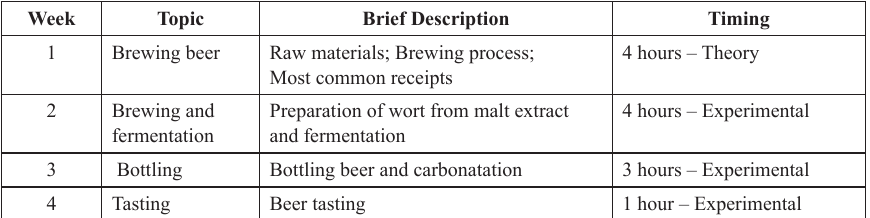
Table 6. Experiment and lecture structure